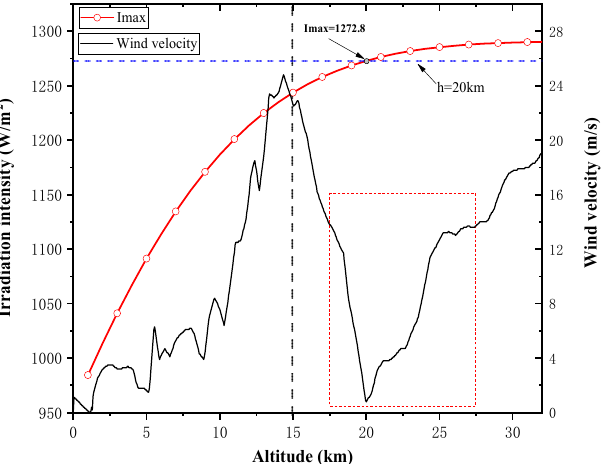
Figure 5. Variations of maximum solar irradiance and wind velocity with altitude.